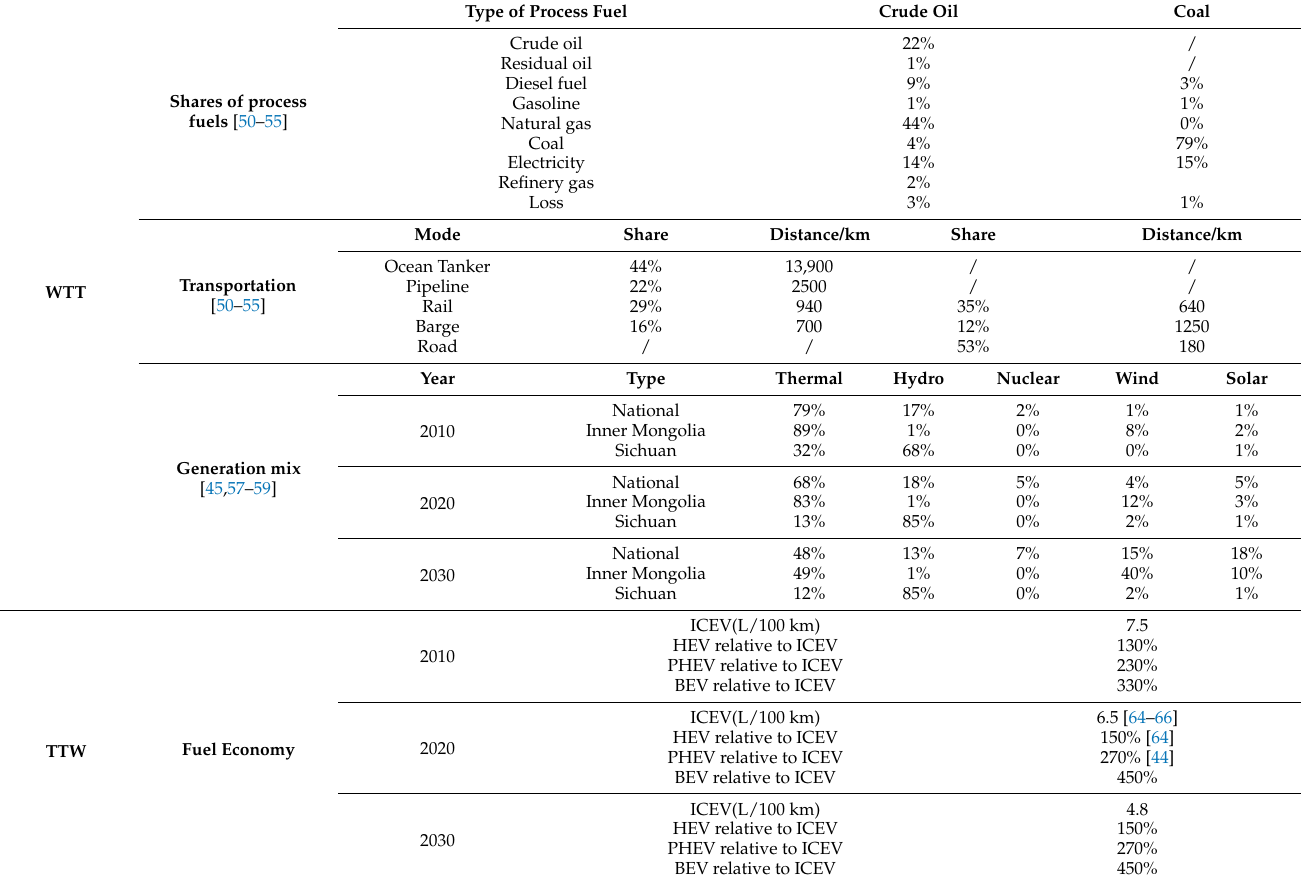
Table 1. Parameters for shares of process fuels, transportation, generation mix and fuel